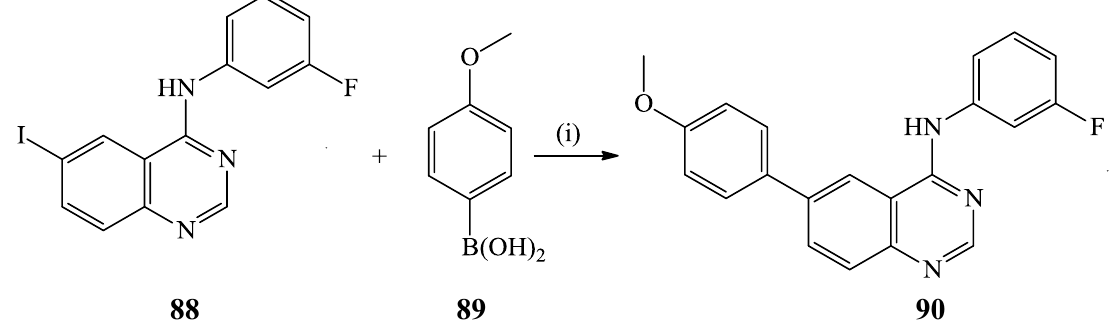
90 Reagents and Conditions : (i) Cs 2 CO 3 , Pd(OAc) 2 , dioxane–water (3:1, v/v), reflux, 30 min. Initial Suzuki-Miyaura cross-coupling of 4-amino-6-iodoquinazoline 91 and furfurylboronic acid in the presence of 10% Pd/C and triethylamine in ethanol under reflux (i) or through C–H activation using PdCl 2 -KOAc mixture (ii) previously afforded the 4-anilino-6-furfurylquinazoline 92 , a precursor for the synthesis of Lapatinib 3 (Scheme 30)